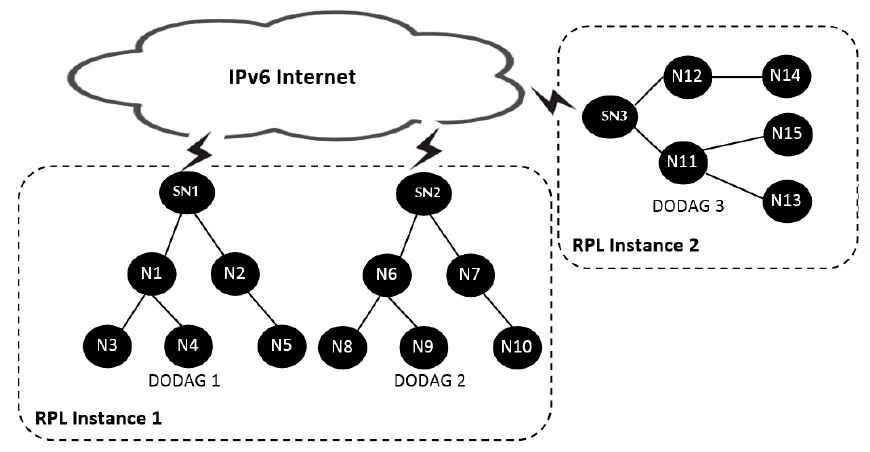
Figure 1. An Example RPL Network.